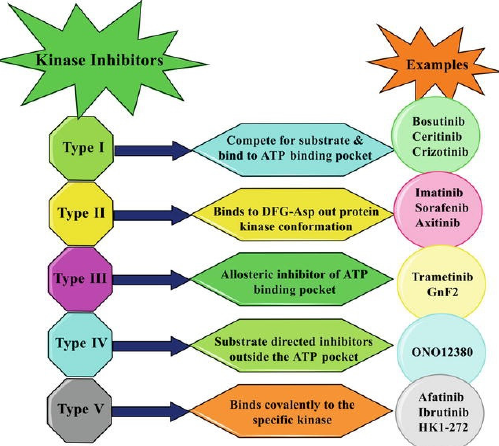
Figure 3. Inhibitory patterns of different kinase inhibitors. Adapted from [63], Copyright 2021 IntechOpen.